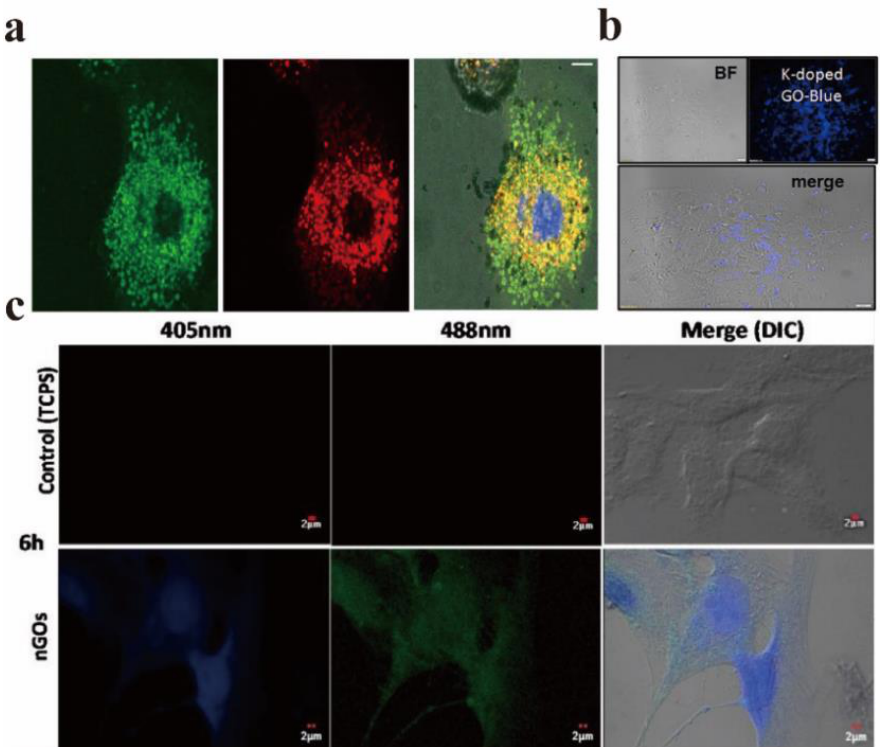
Figure 16. ( a ) Highly obvious co-localization of CHDMA (green pixels in the left image) and lysosome (red pixels in the middle image) in fibroblasts, showing the 3D reconstruction and merging of green and red channels in a plane layer of cells; the central blue circle is the position of the nucleus. Reprinted with permission from [95]. Copyright 2019, Elsevier. ( b ) Confocal microscopic images of cells with potassium-doped GO as fluorescence probe. Reprinted with permission from [97]. Copyright 2019, Elsevier. ( c ) Confocal microscopy images of human vascular smooth muscle cells cultured with 1% NGOs for 6 h. Reprinted with permission from [98]. Copyright 2020, Elsevier.